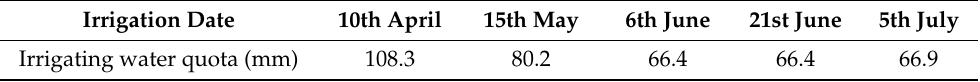
Table 3. The irrigation schedule for